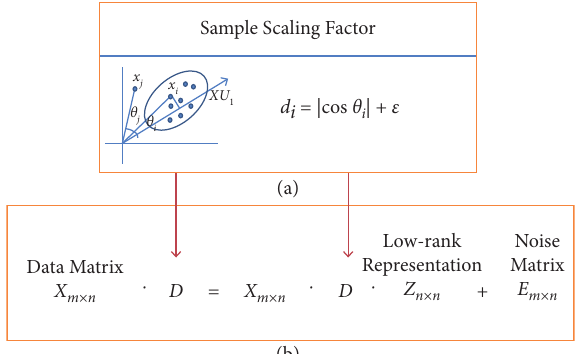
Figure 1: Our proposed model’s